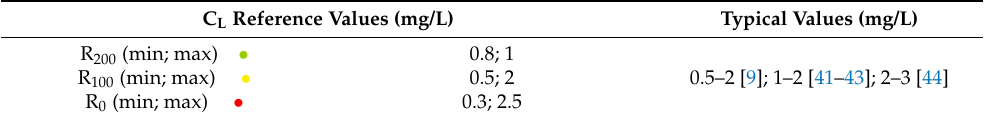
Table 2. The reference values for the dissolved oxygen concentration in the AS